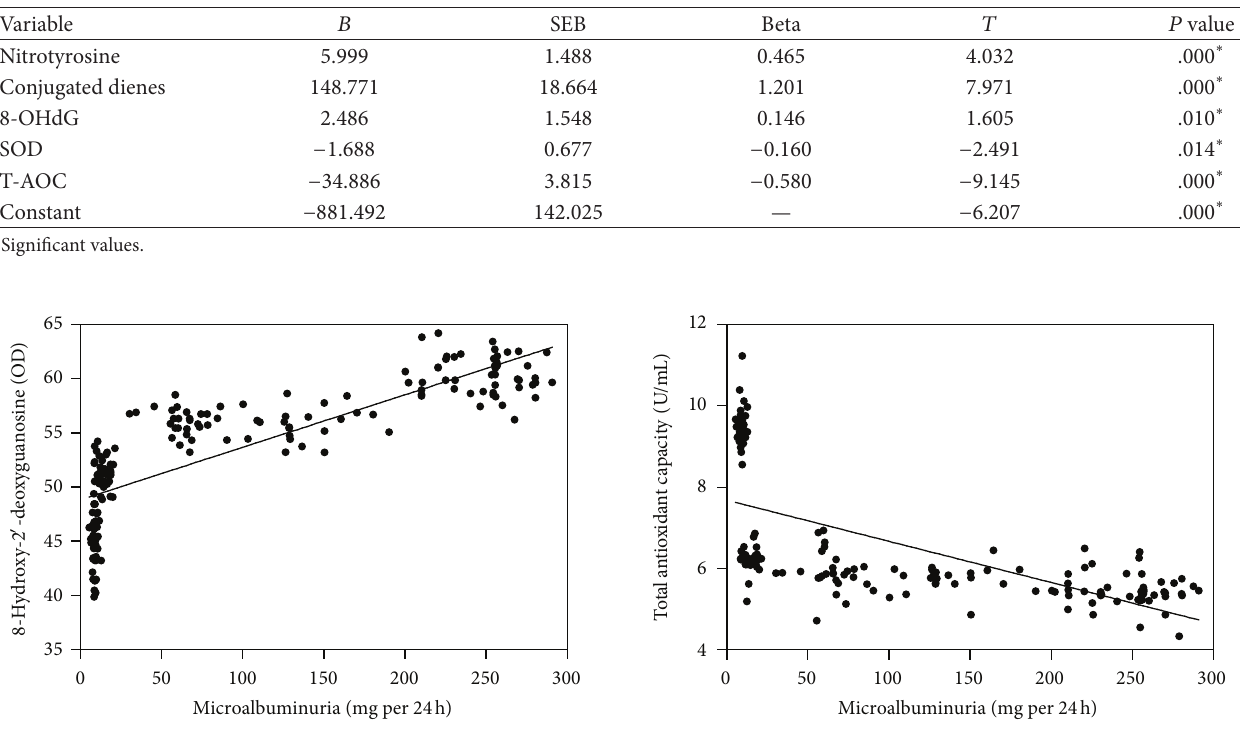
F 5: Correlation between microalbuminuria levels and total antioxidant